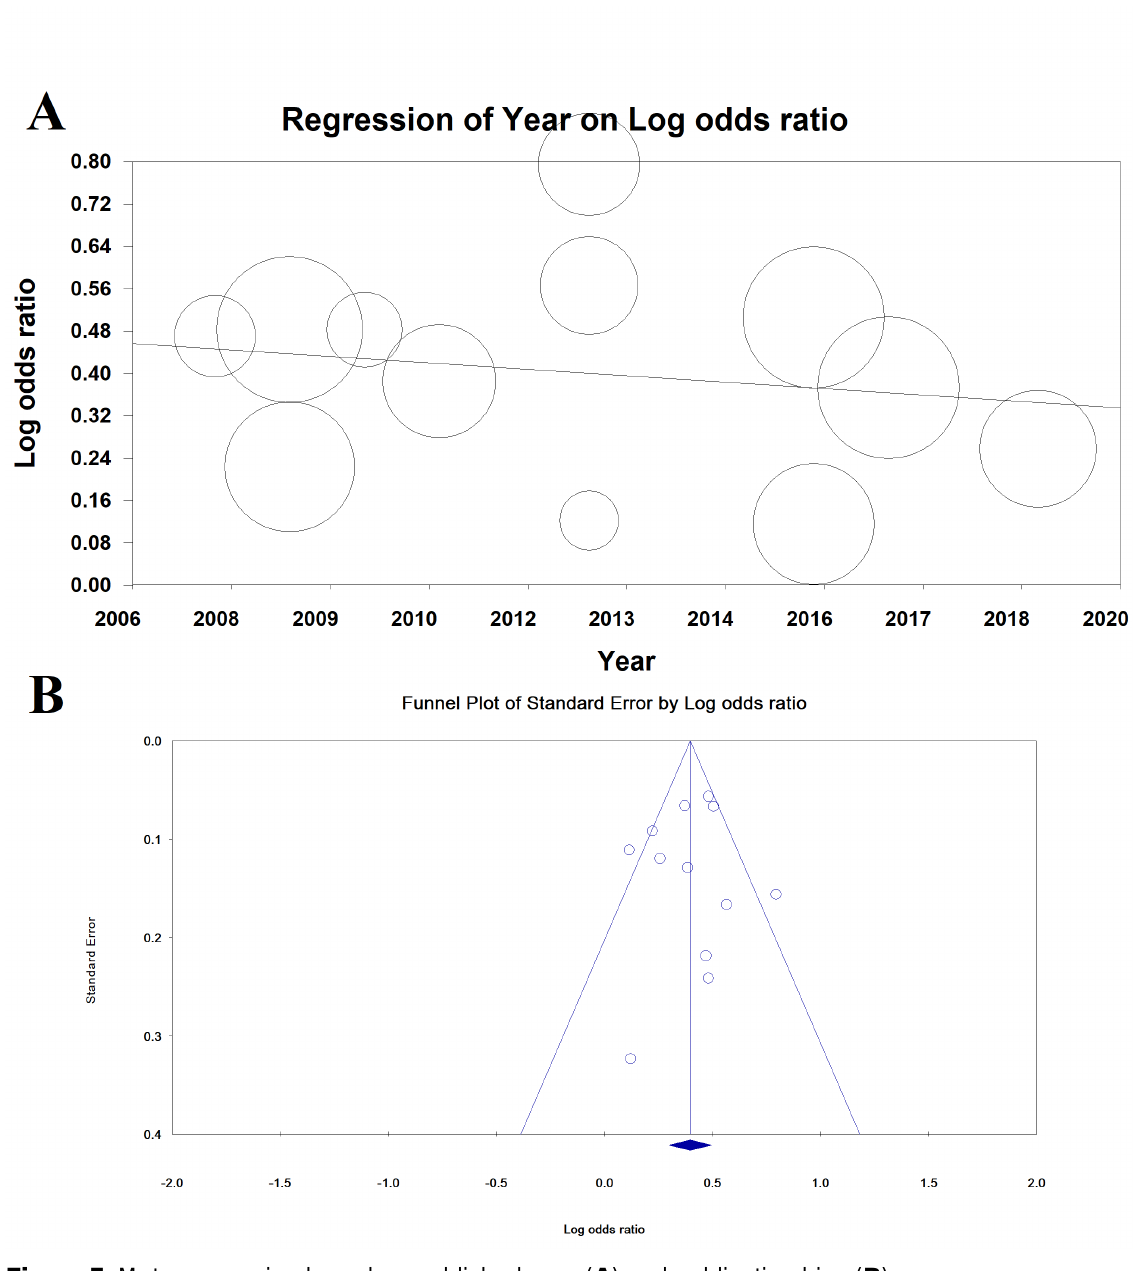
Figure 5: Meta-regression based on published year ( A ) and publication bias ( B